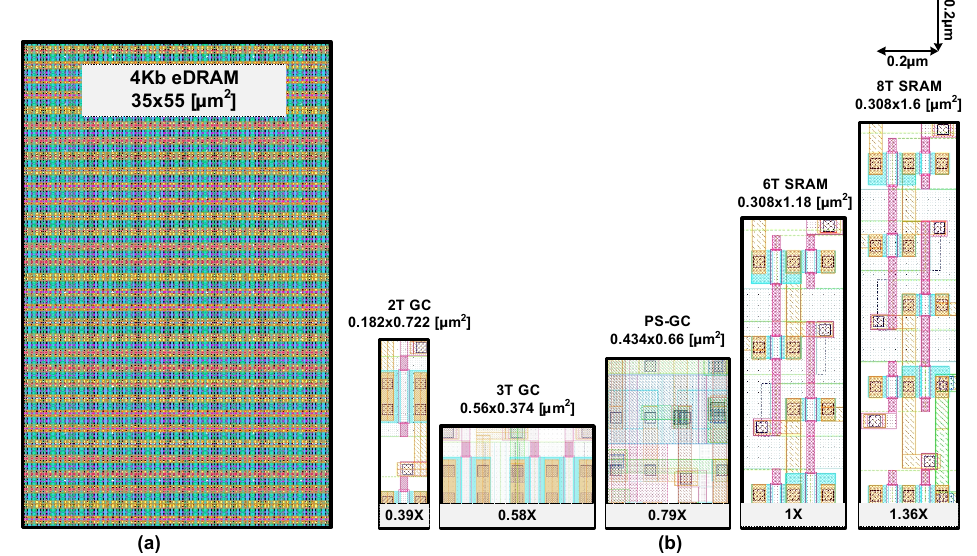
Figure 12. ( a ) Proposed 4 kb macro layout. ( b ) Layout comparison of bit cells of eDRAMs and SRAMs.